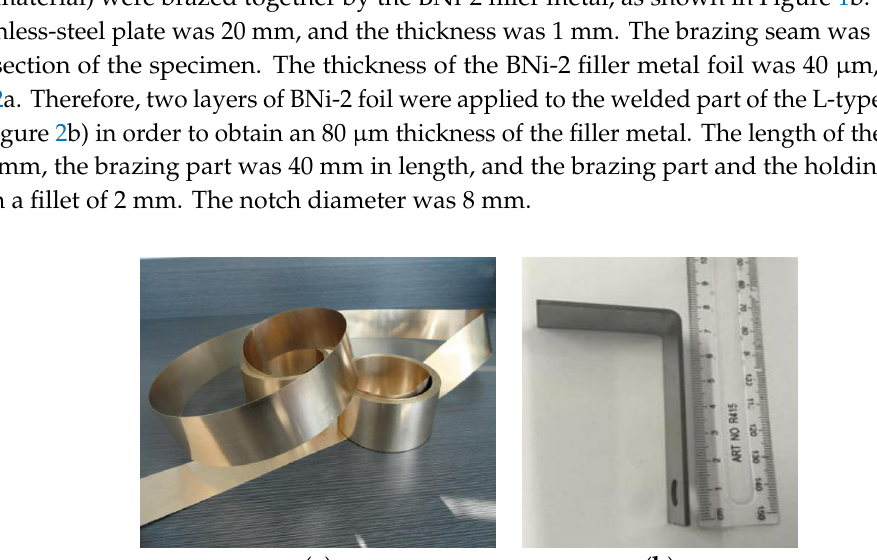
Figure 2. Brazing joint parts: ( a ) BNi-2 foil and ( b ) L-type 304 stainless steel.